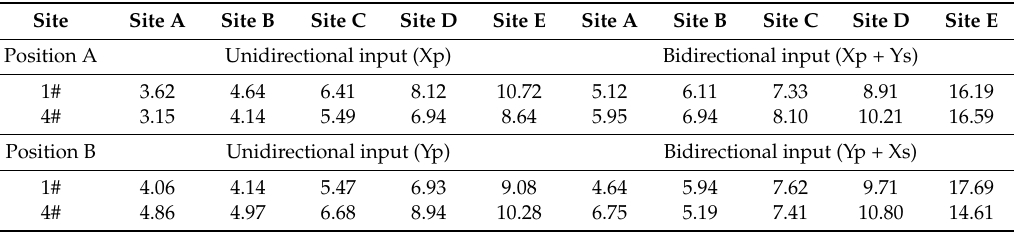
Table 6. Displacement response of beam end (unit.mm).